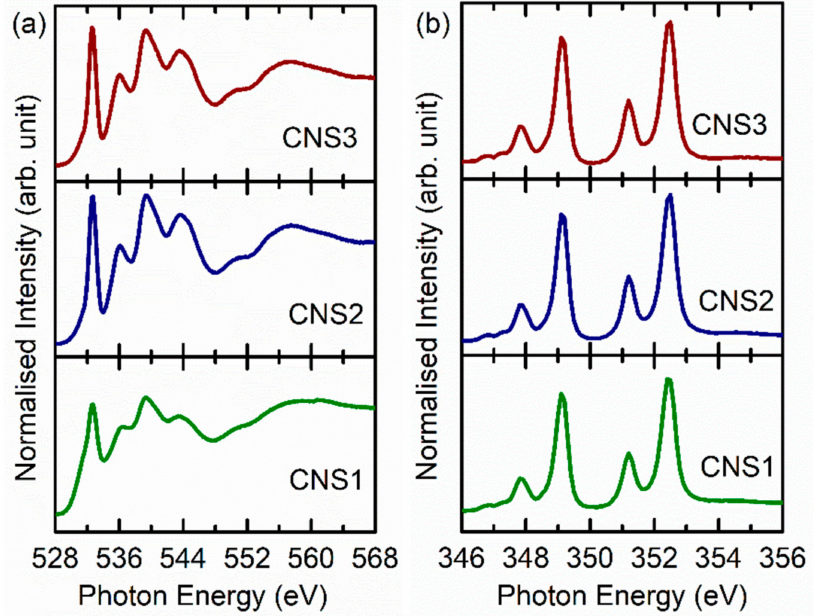
Figure 8. ( a ) O K -edge, and ( b ) Ca L -edge NEXAFS spectra of CNS1, CNS2 and CNS3